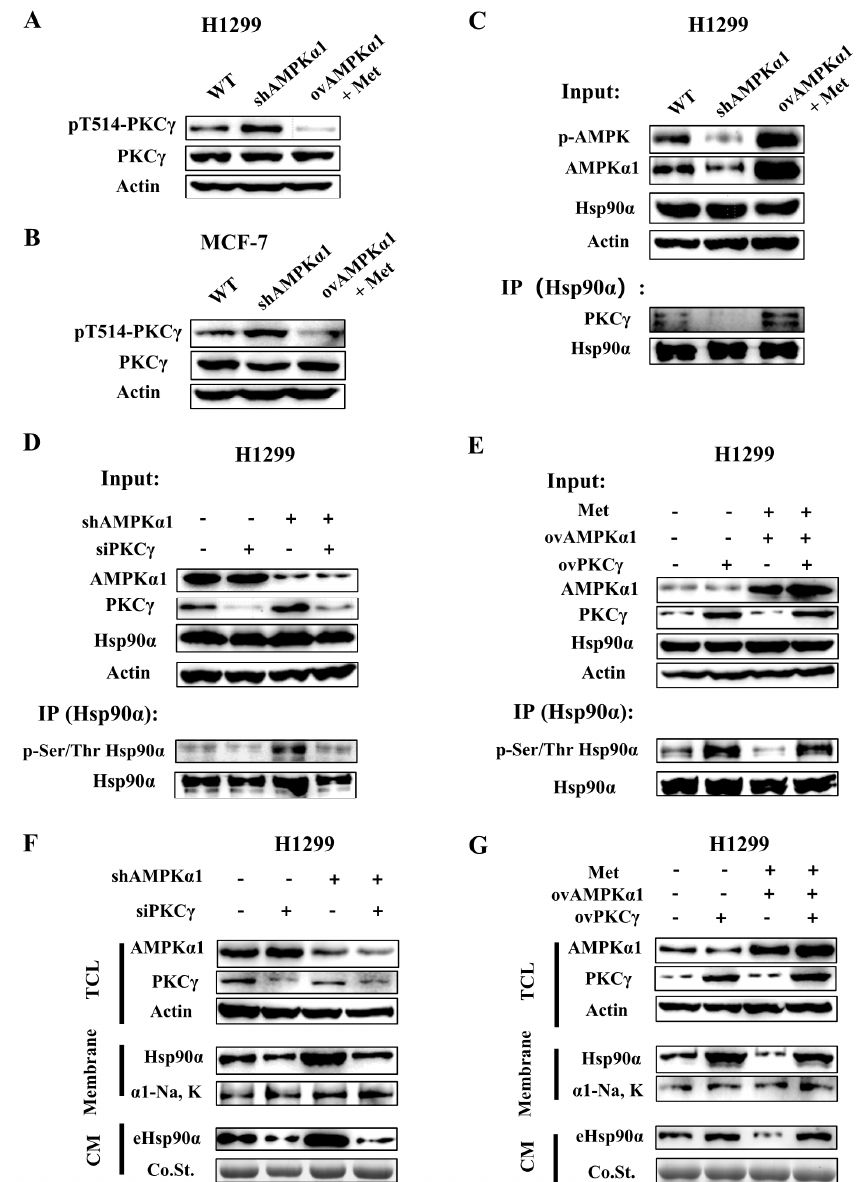
Figure 6. AMPK α 1 inhibits Hsp90 α phosphorylation, membrane translocation and secretion by suppressing the kinase activity of PKC γ . pT514-PKC γ , PKC γ and actin were measured by Western blot in H1299-WT, KD and OV cells ( A ) and MCF-7-WT, KD and OV cells ( B ) The level of pT514 is an indicator of PKC γ activation. ( C ) Hsp90 α was pulled down in H1299-WT, KD and OV cells treated with or without metformin. PKC γ was measured by western blot. ( D ) Hsp90 α was pulled down in WT, AMPK α 1-KD, PKC γ -KD and AMPK α 1-PKC γ -double KD H1299 cells. The phosphorylation level of Hsp90 α at Ser/Thr was measured by western blot. ( E ) Hsp90 α was pulled down in WT, AMPK α 1-OV, PKC γ -OV and AMPK α 1-PKC γ -double OV H1299 cells treated with or without metformin. The phosphorylation level of Hsp90 α at Ser/Thr was measured by western blot. ( F ) Plasma membrane extractions and conditioned medium of WT, AMPK α 1-KD, PKC γ -KD and AMPK α 1-PKC γ -double KD H1299 cells were analyzed by western blot. Na, K-ATPase α 1 was the plasma membrane marker. ( G ) Plasma membrane extractions and conditioned medium of WT, AMPK α 1-OV, PKC γ -OV and AMPK α 1-PKC γ -double OV H1299 cells treated with or without metformin were analyzed by western blot. Na, K-ATPase α 1 was the plasma membrane